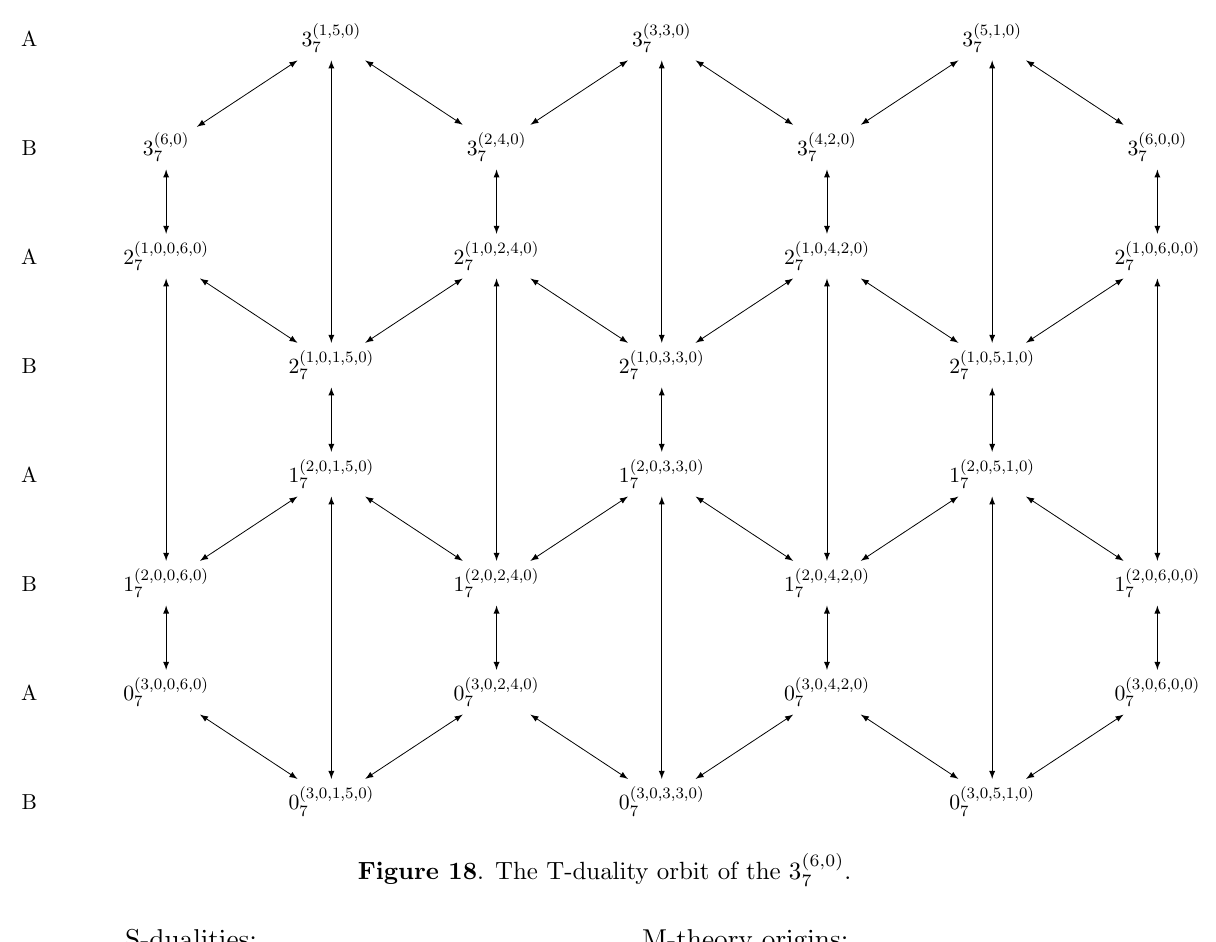
Figure 18 . The T-duality orbit of the 3 (6 ; 0)